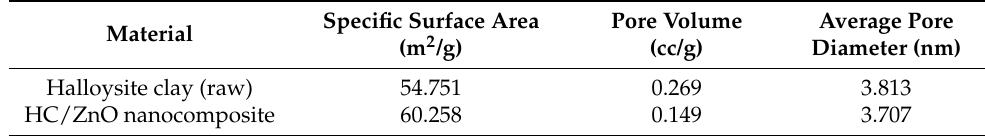
Figure 10. ( a , b ) FE-SEM micrographs; ( c ) HR-TEM images; ( d ) SAED pattern; ( e ) EDS spectra and elemental table of HC/ZnONC. Table 2. Surface area, total pore volume, and average pore size of